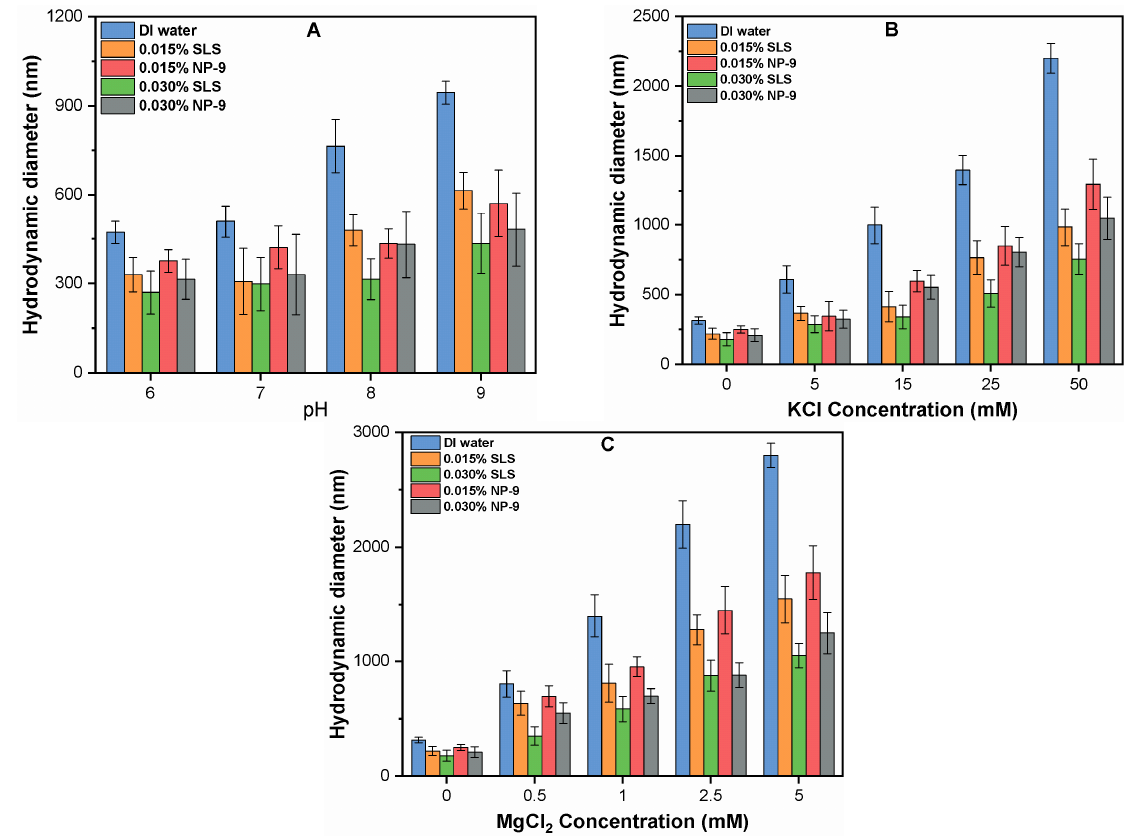
Figure 5. Effect of surfactants concentration (0–0.030%) on HDD of CuO NPs as a function of ( A ) pH; ( B ) KCl; and ( C ) MgCl 2